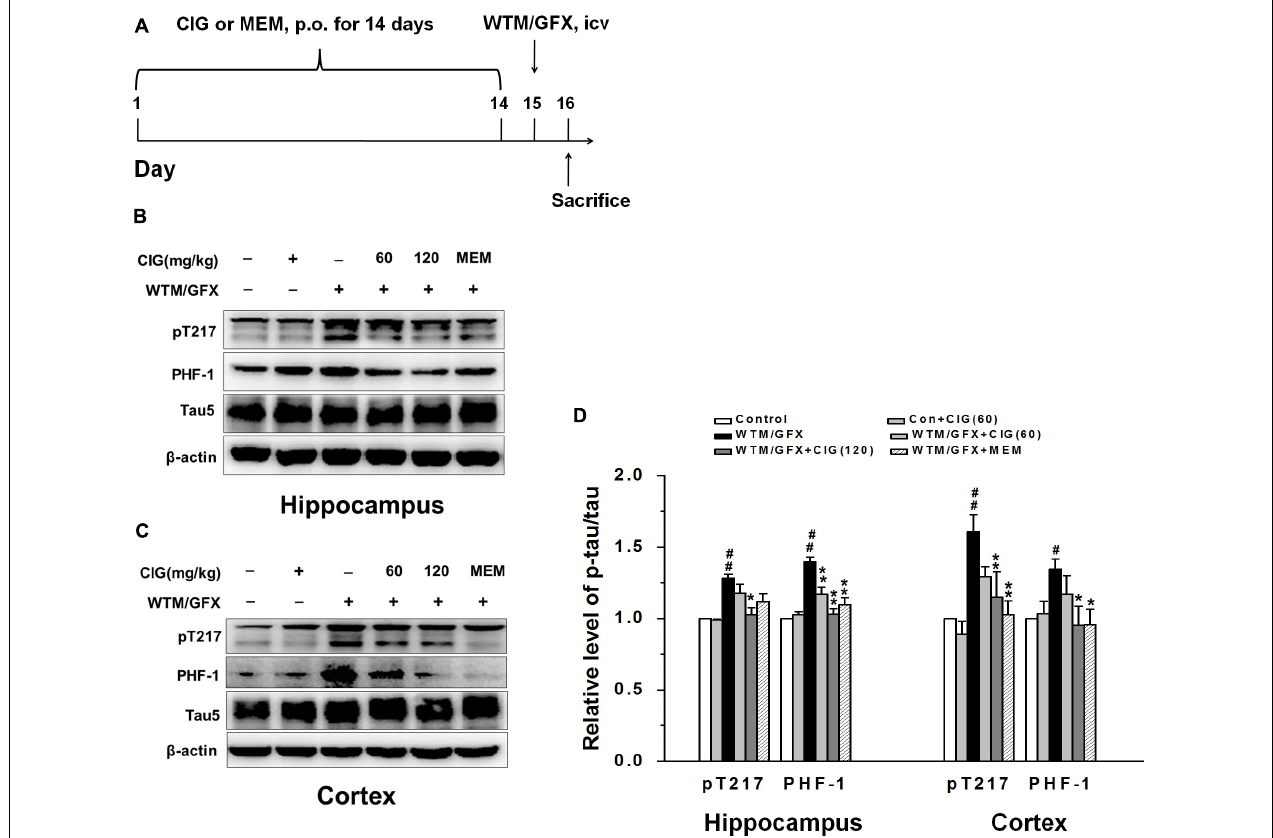
FIGURE 1 | Cornel iridoid glycoside (CIG) inhibits tau hyperphosphorylation and GSK-3 β induced by wortmannin/GFX in rats. (A) Flow chart of experimental schedule. (B–D) The phosphorylated tau protein at Thr217, PHF-1 and total tau5 in the hippocampus and cortex detected by western blotting assay. β -actin was used as an internal control, and the expression level of control group was set as 100%. Data are expressed as mean ± SD; n = 4 per group. # P < 0.05, ## P < 0.01, the model group compared with the control group; ∗ P < 0.05, ∗∗ P < 0.01, drug groups compared with the model group. WTM, wortmannin; GFX, GF-109203X; MEM, memantine, 3 mg/kg; p.o., intragastric administration; icv, intracerebroventricular